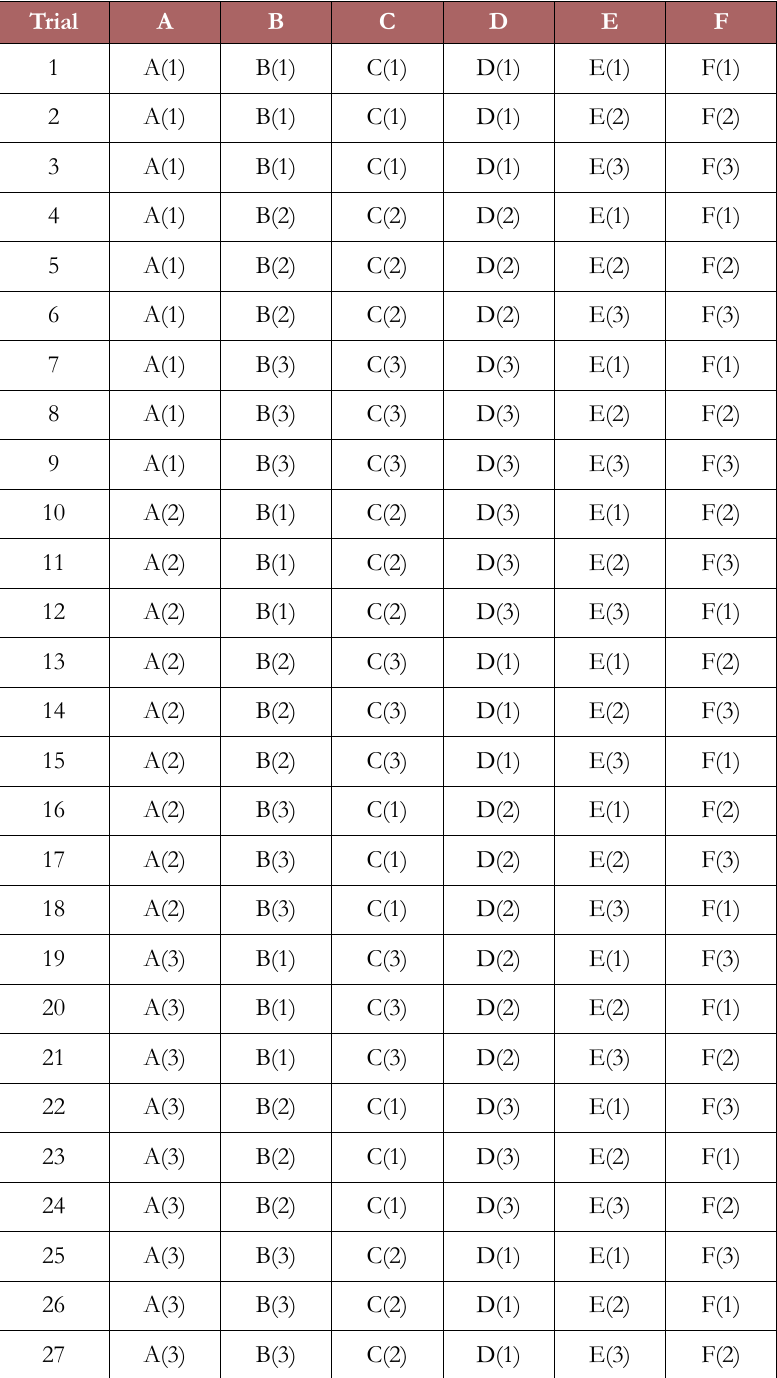
Table 3. L27 orthogonal array for ICASA